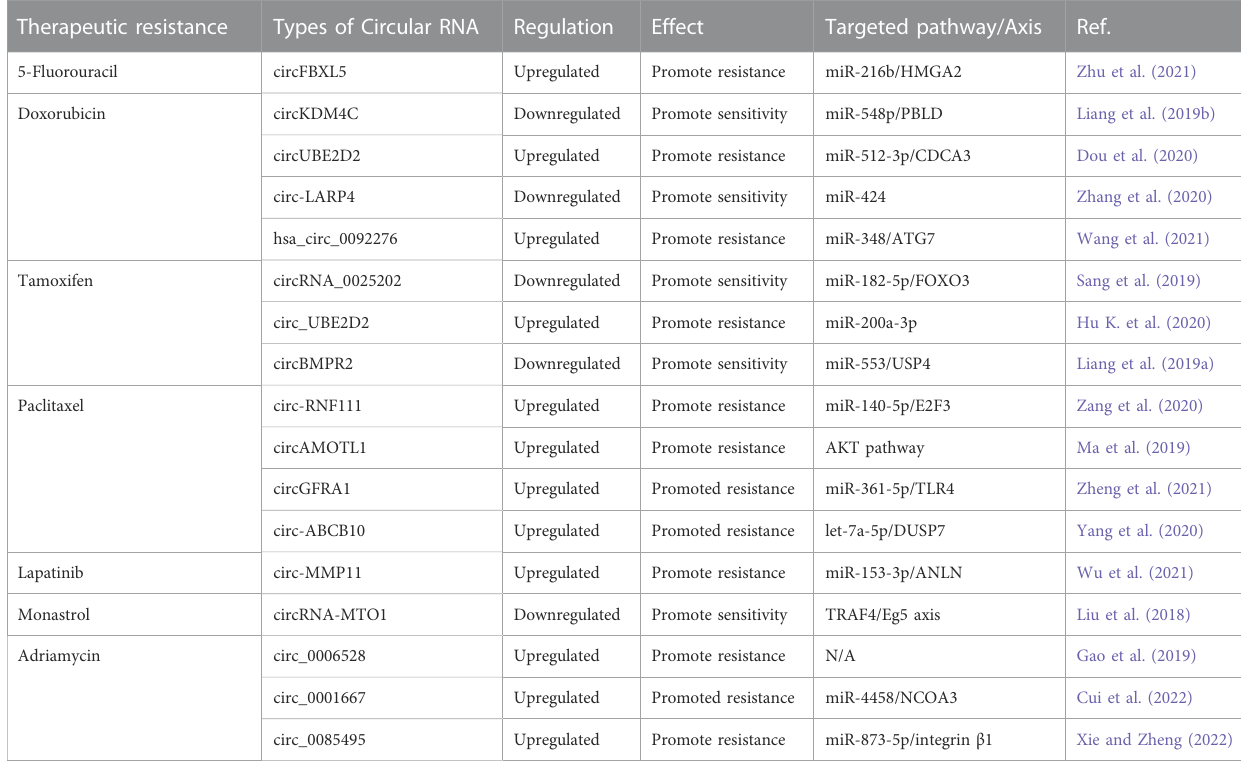
TABLE 3 Exo-circRNAs in breast cancer promotes therapeutic resistance. Therapeutic